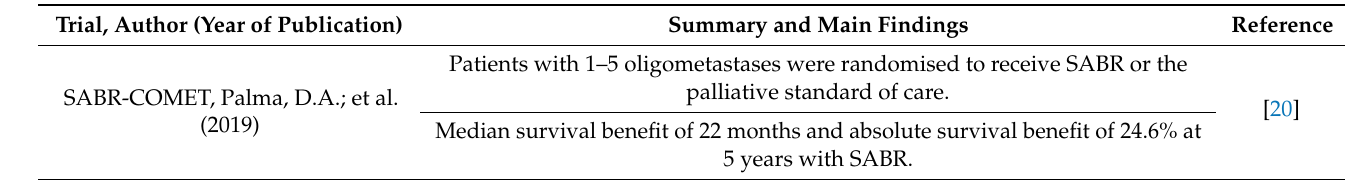
Table 1. Radiotherapy for oligometastatic disease; summary of key trial